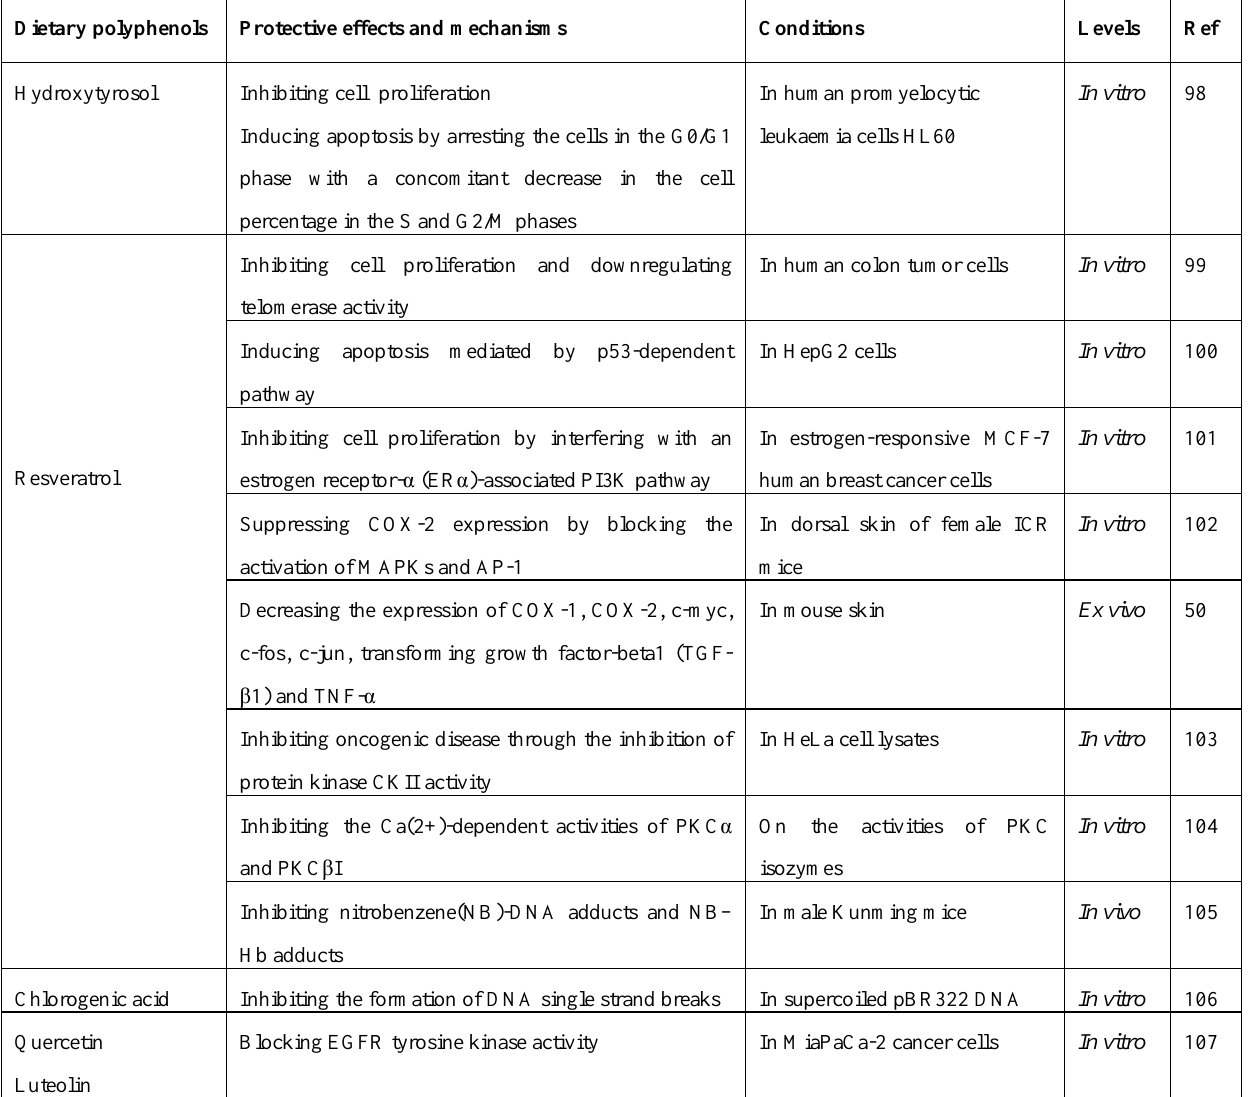
Table 6. Antimutagenic/anticarcinogenic properties of dietary